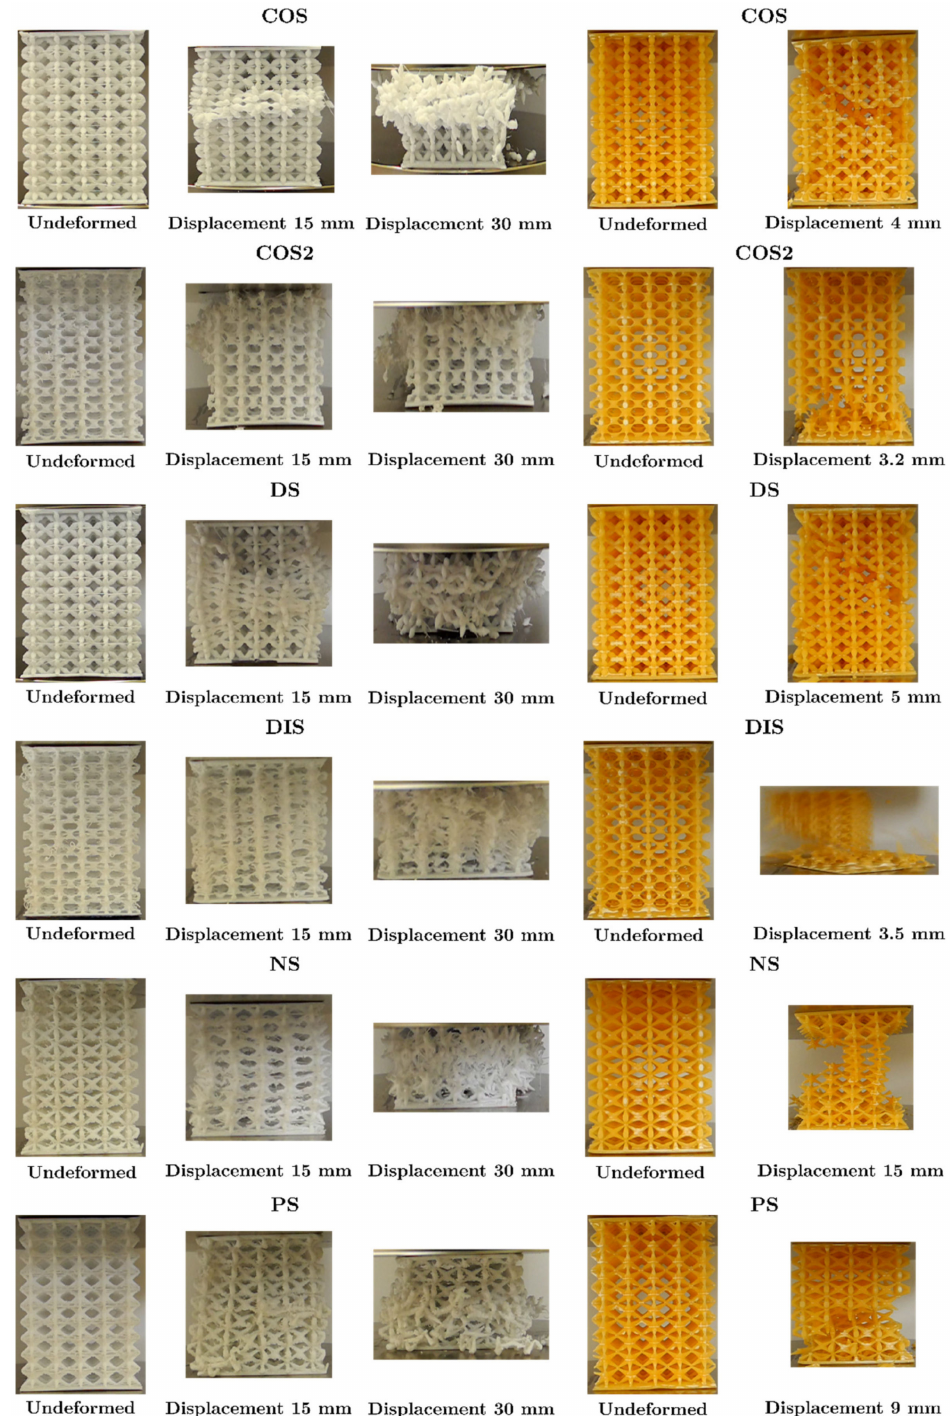
Figure 17. Deformation stages during the compression test. Left: lattice structures fabricated with PLA; Right: lattice structures fabricated with